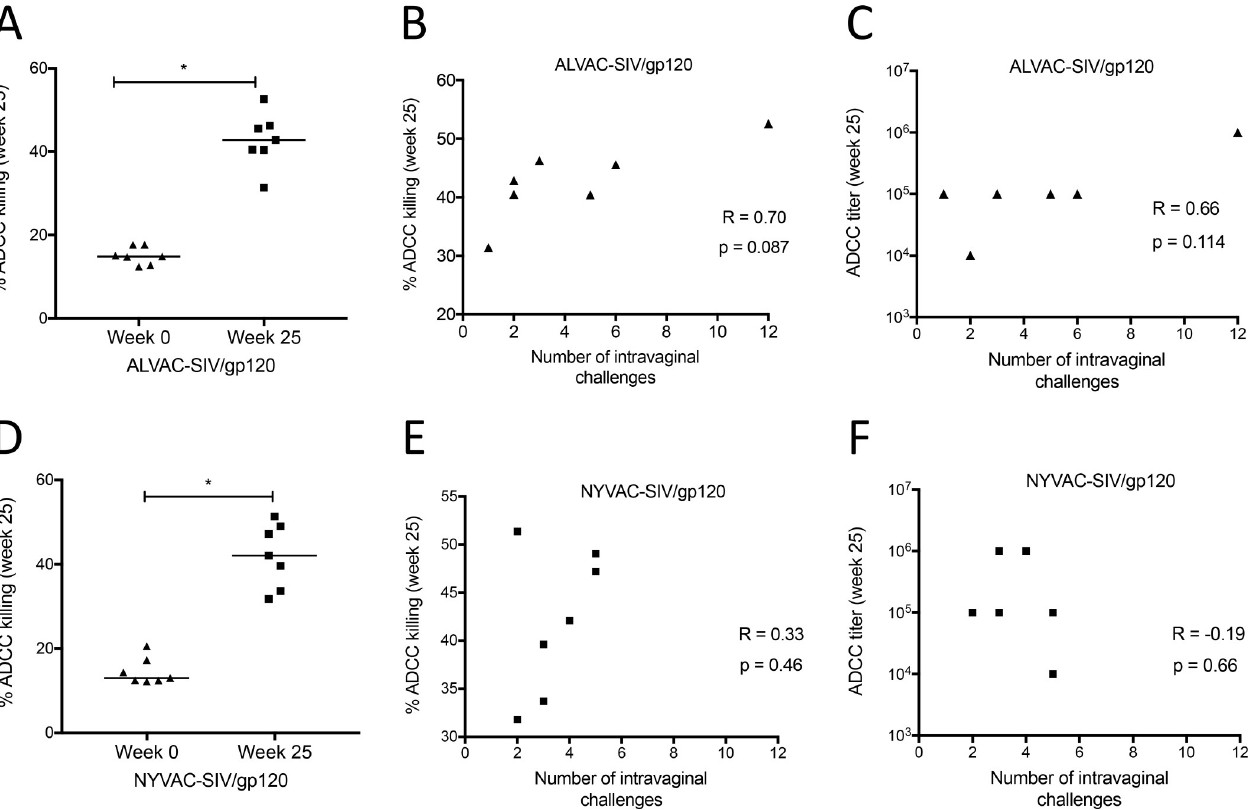
Fig 3. ADCC activity in ALVAC-SIV/gp120 and NYVAC-SIV/gp120 vaccinated animals. Comparison of percent ADCC killing between pre-immunization and one week post-final immunization (week 25) in (A) 7 ALVAC and (D) 7 NYVAC-vaccinated macaques. (B,C) A positive correlation was observed between the number of intravaginal challenges and the percentage of ADCC killing or ADCC titers in ALVAC-vaccinated macaques. (E,F) Correlation analysis between the number of intravaginal challenges to infection and the percentage of ADCC killing or ADCC titers in 7 NYVAC-vaccinated macaques. Horizontal lines represent the